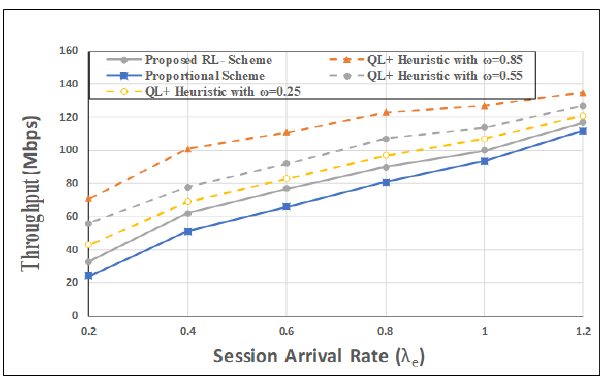
Figure 5. Aggregated throughput experienced by both slices in uplink as a function of the eMBB session generation rate λe (sessions/s).